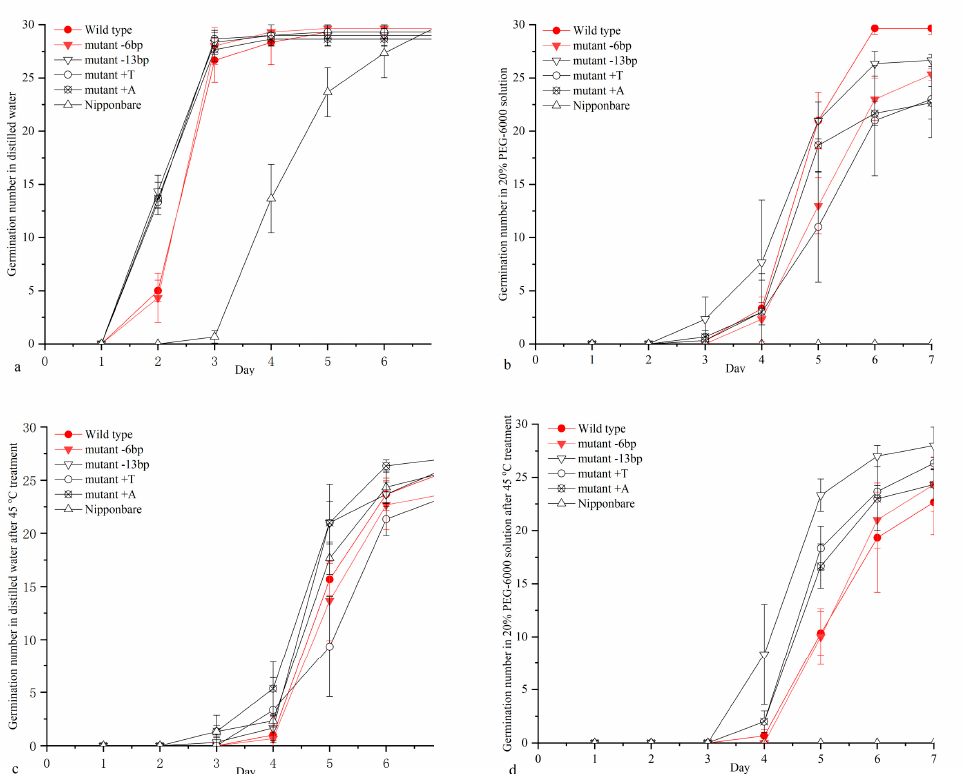
Figure 4. Drought tolerance in seed germination of wild type and T3 mutant of weedy rice. Note: Four treatments including with distilled water germination ( a ), 20%PEG-6000 drought-tolerant germination ( b ), distilled water germination after weak dormancy breaking ( c ), and 20%PEG-6000 drought-tolerant germination after weak dormancy breaking ( d ), respectively. Three-time replicates were carried out for seed germination, and for each replication, 30 seeds were used. Wild type is Wrl-162. Mutants are Rc1-162-18, Rc1-162-1, Rc1-162-16, and Rc1-162-17. Wild type weedy rice and rice cultivar (Nipponbare) as control.